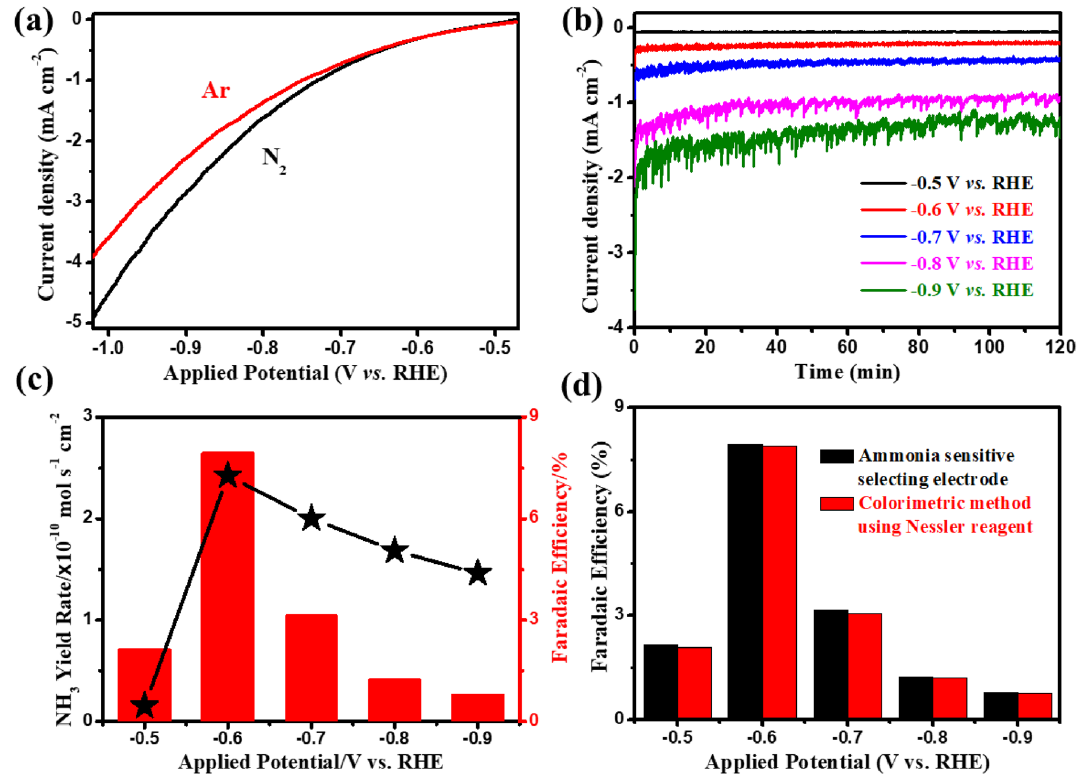
Fig. 4 Electrocatalytic performance of N@ZnS/Zn electrode for ENRR. a LSV in N 2 - and Ar-saturated electrolytes; b It-curves from chronoamperometry tests under different potentials; c Calculated FE